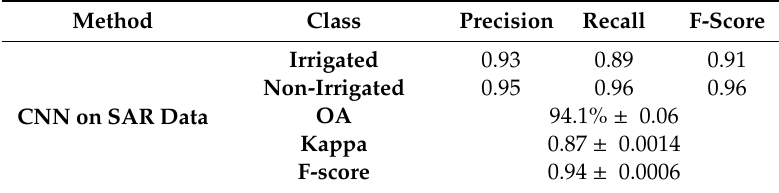
Table 7. The values of the overall accuracy, Kappa, F-score, precision, and recall obtained from the CNN method on SAR data.